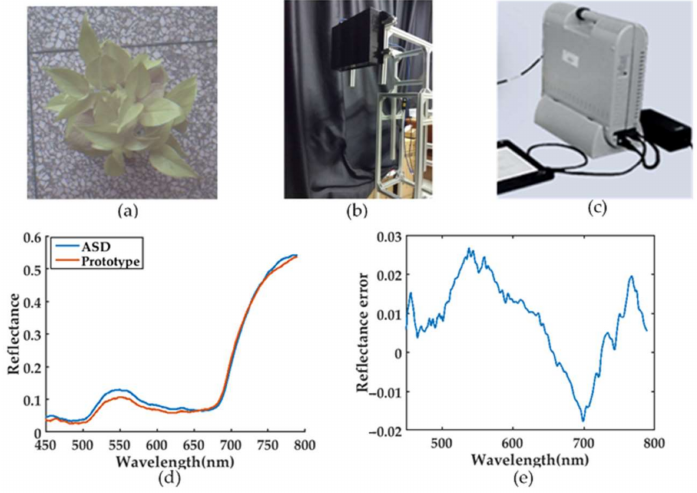
Figure 10. The spectral measurement with ASD and prototype. ( a ) Epipremnum aureum ; ( b ) The prototype; ( c ) The ASD spectrometer; ( d ) Result comparison between prototype and ASD; ( e ) The errors relative to